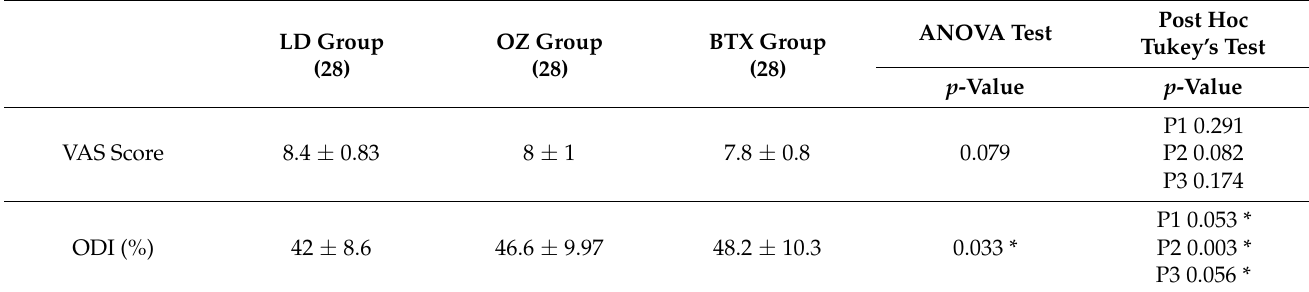
Table 2. Baseline (pre-injection) data of the three studied groups.